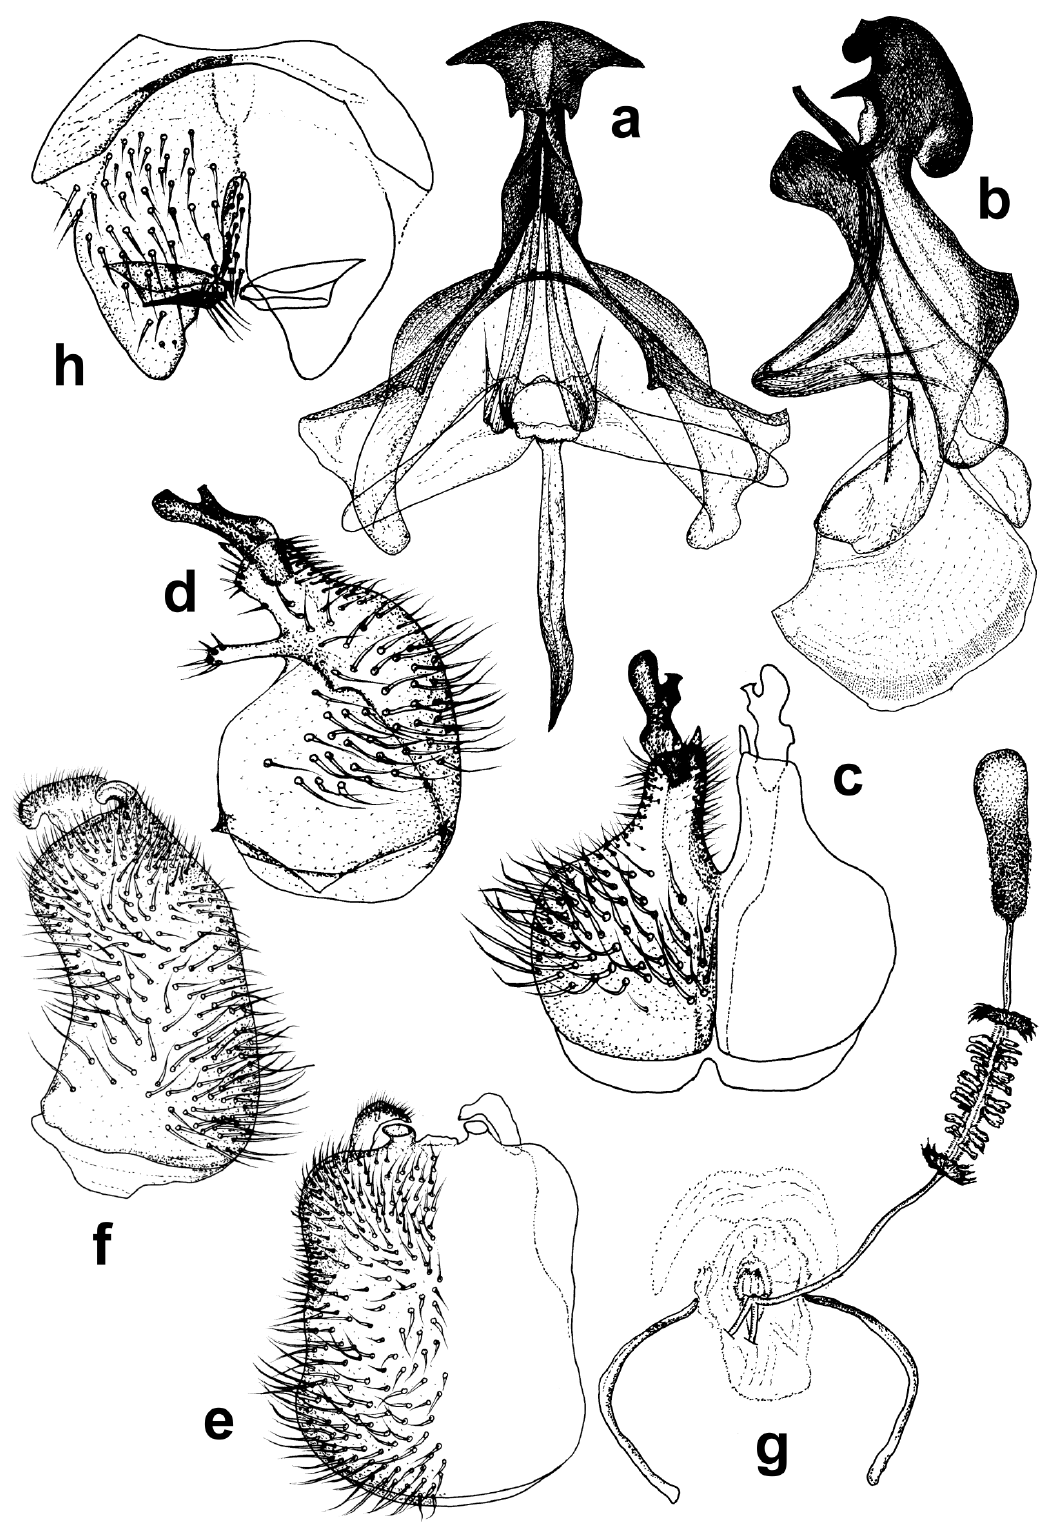
Fig. 38. Parageron orientalis Paramonov, 1929 stat. rev. a . Epiphallic complex ventral. b . Epiphallic complex lateral. c . Gonocoxite ventral. d . Gonocoxite lateral. e . Epandrium dorsal. f . Epandrium lateral. g . Female genitalia ventral. h . Female sternite 8